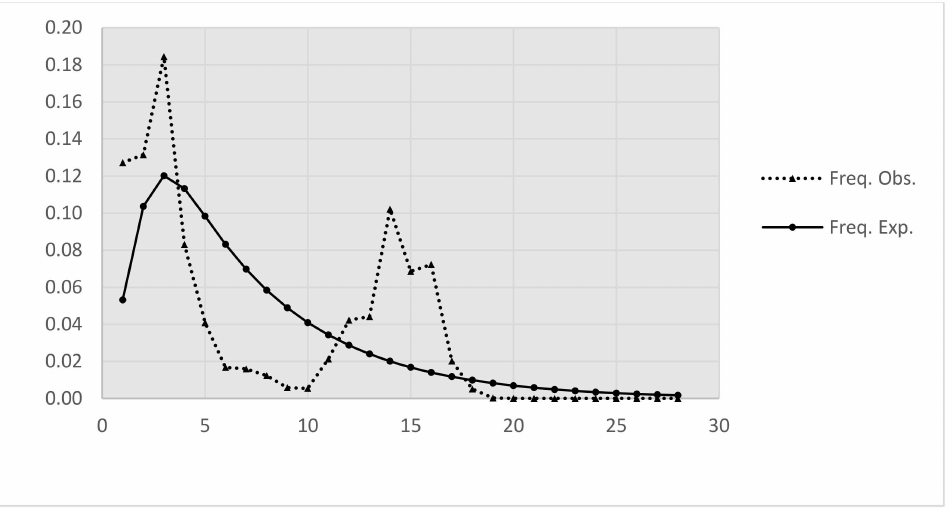
Figure 4. Mismatch distribution of Aedes aegypti populations in Vietnam. The dotted line represents the observed distribution of pairwise differences between pairs of mitochondrial COI haplotypes, whereas the solid line illustrates the expected distribution under the population